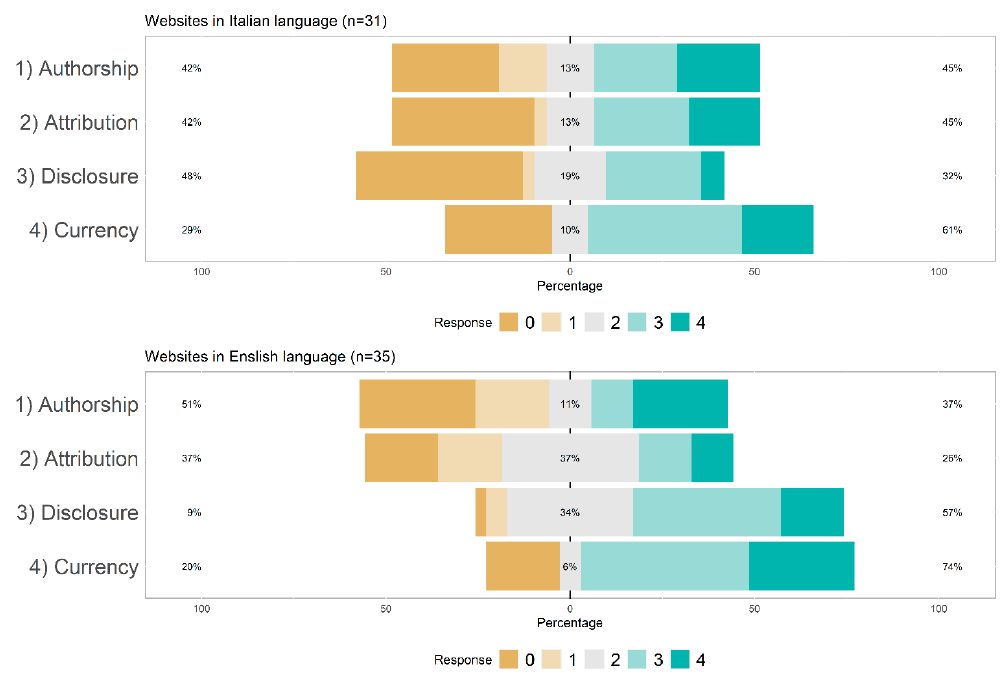
Figure 2. Distribution of the adherence to the JAMA benchmark criteria in Italian and English websites.